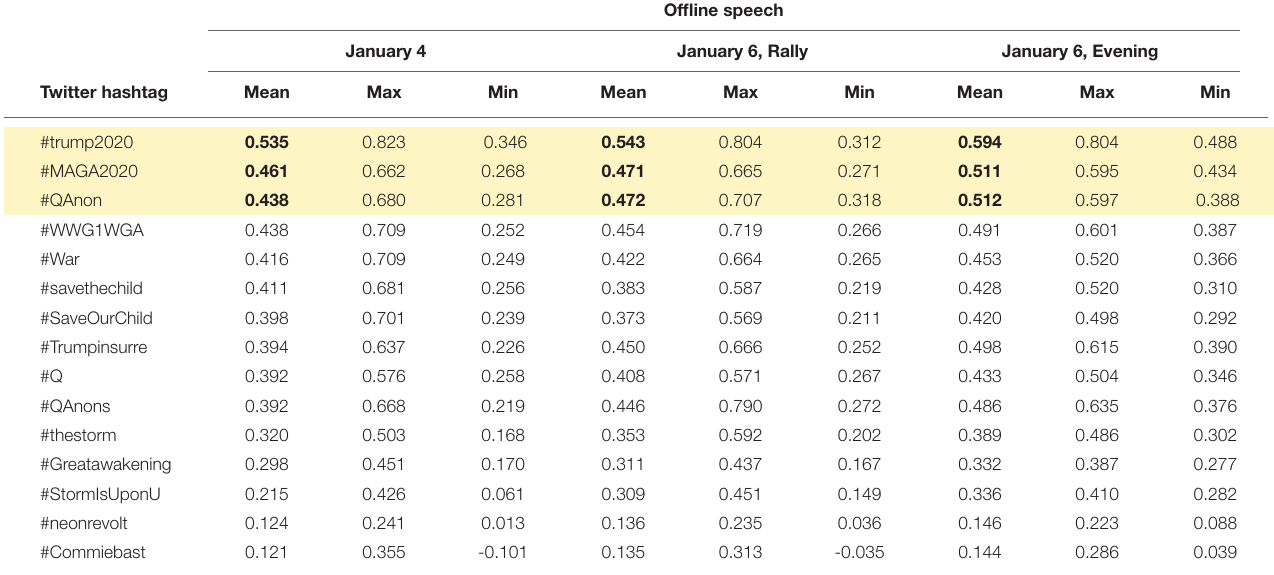
TABLE 1A | Descriptive statistics: similarity scores comparing offline speech and tweets (Full